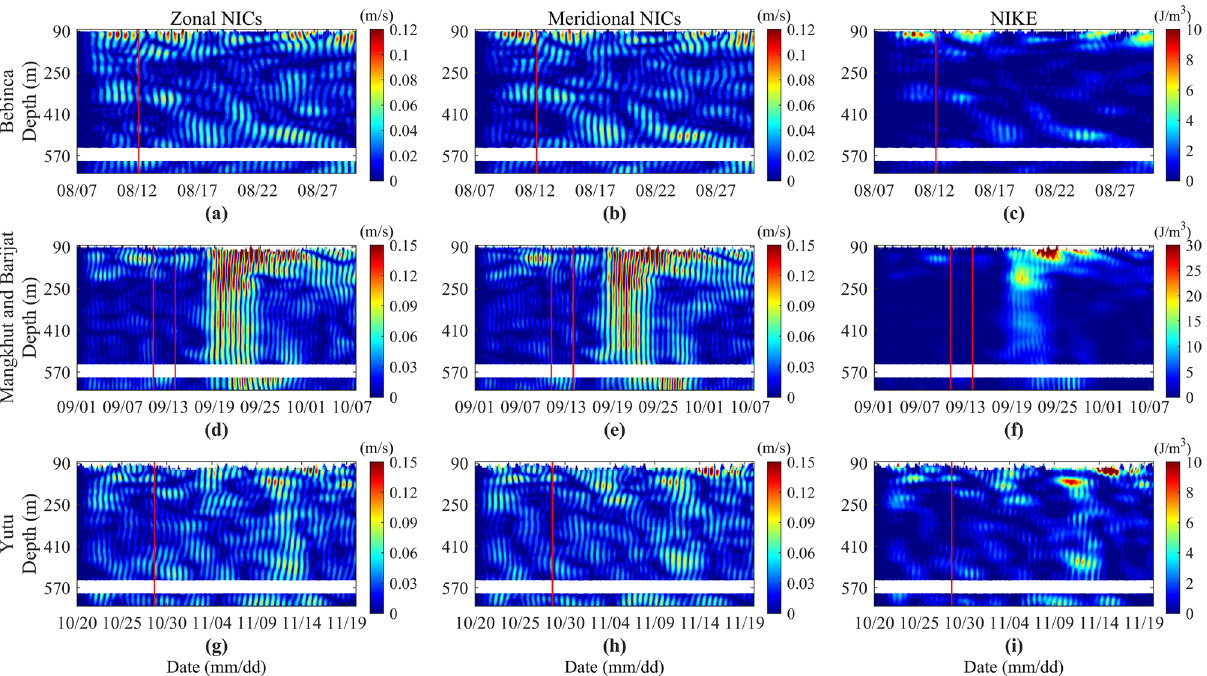
Figure 4. Spatio-temporal distribution of zonal and meridional NICs and NIKE during the passage of typhoons Bebinca ( a–c ), Barijat and Mangkhut ( d–f ), and Yutu ( g–i ), respectively. The red vertical lines are same as Fig.